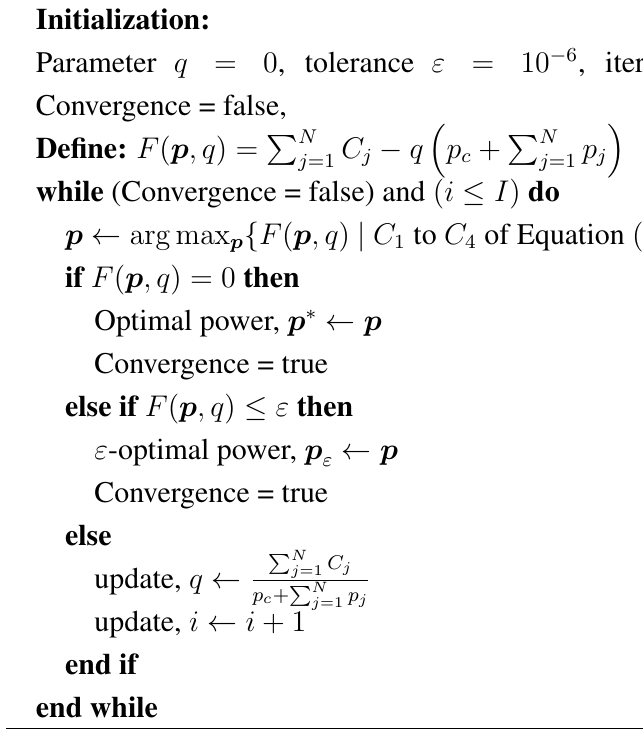
Algorithm 1 : Iterative algorithm based on the Dinkelbach